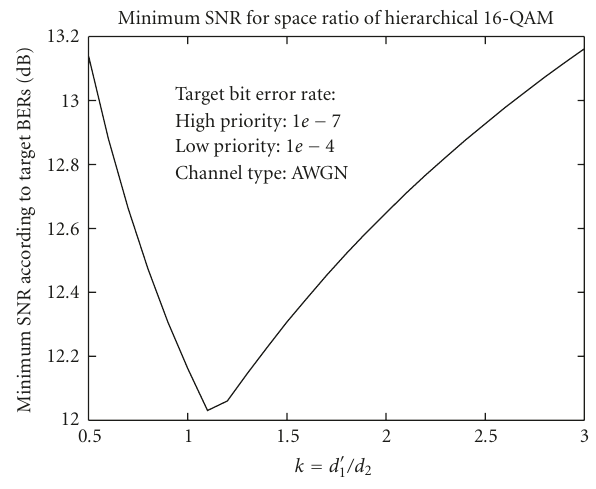
Figure 6: SNR versus k